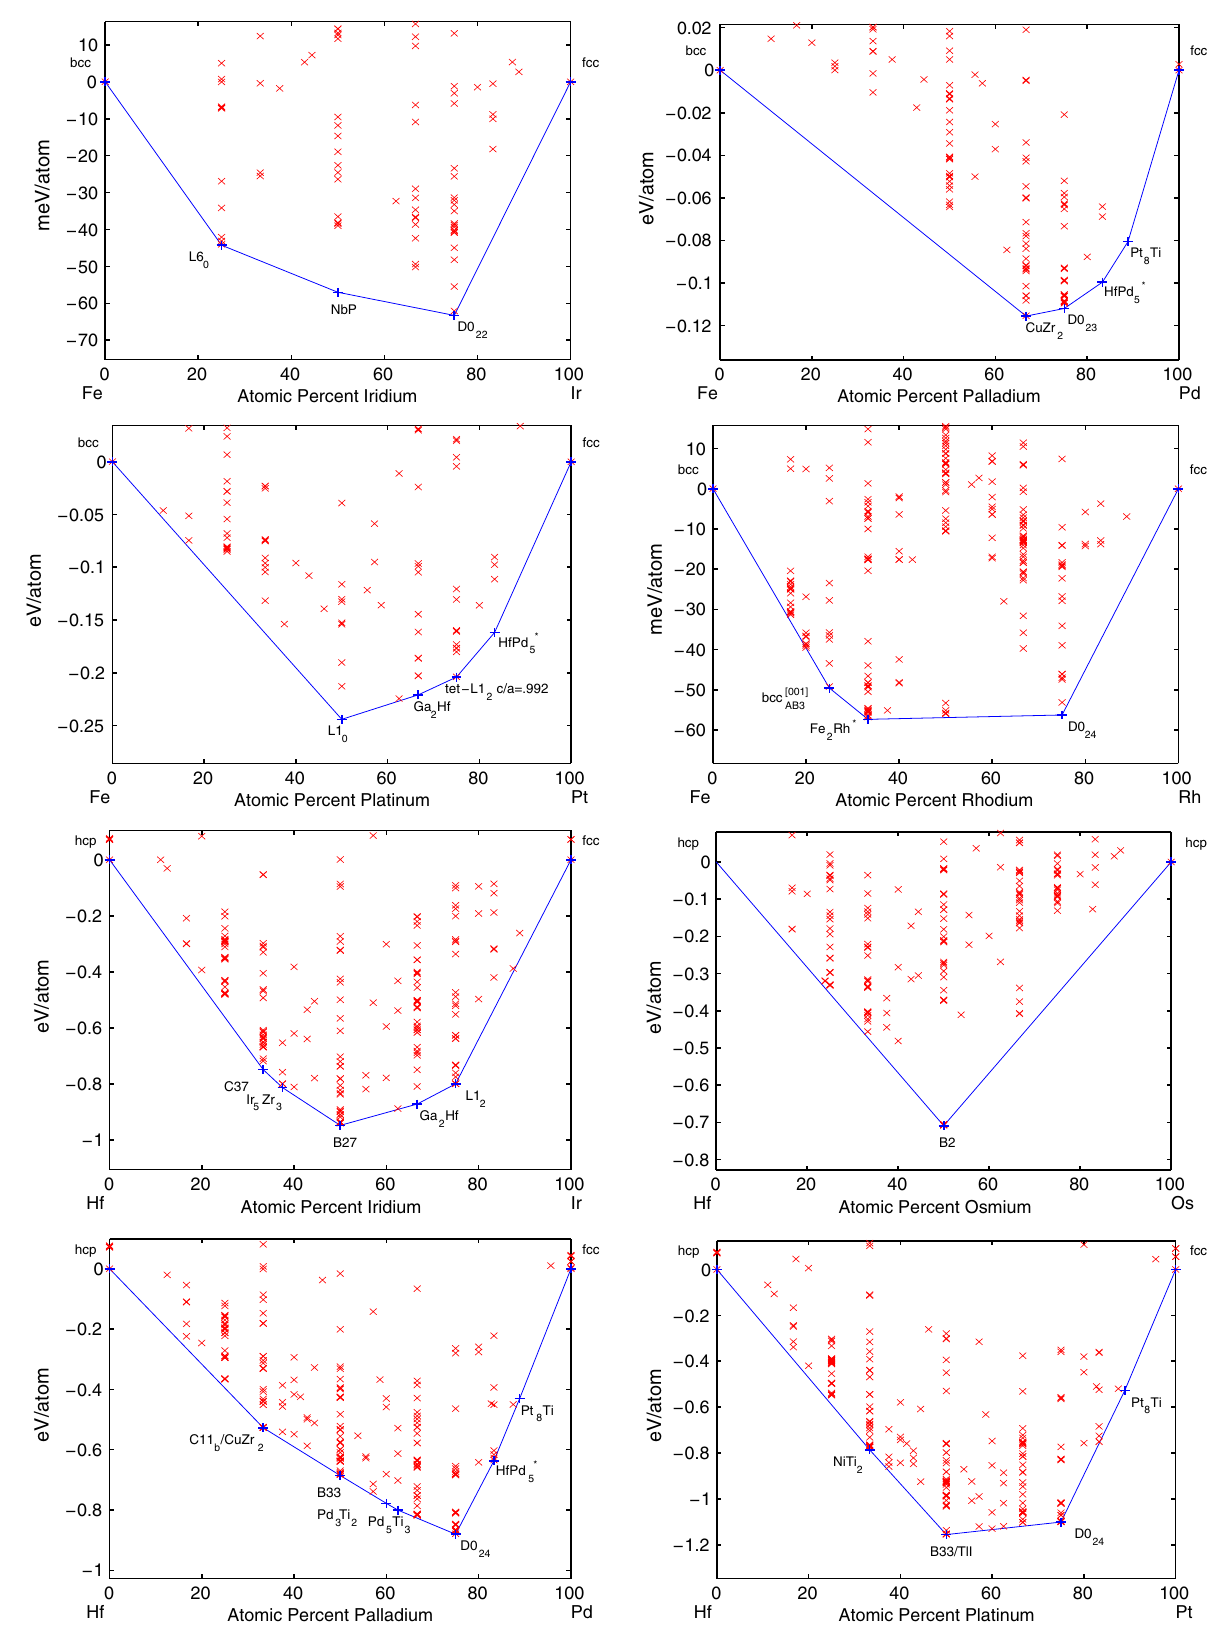
FIG. 7. Convex hulls for the systems Fe-Ir, Fe-Pd, Fe-Pt, Fe-Rh, Hf-Ir, Hf-Os, Hf-Pd, and